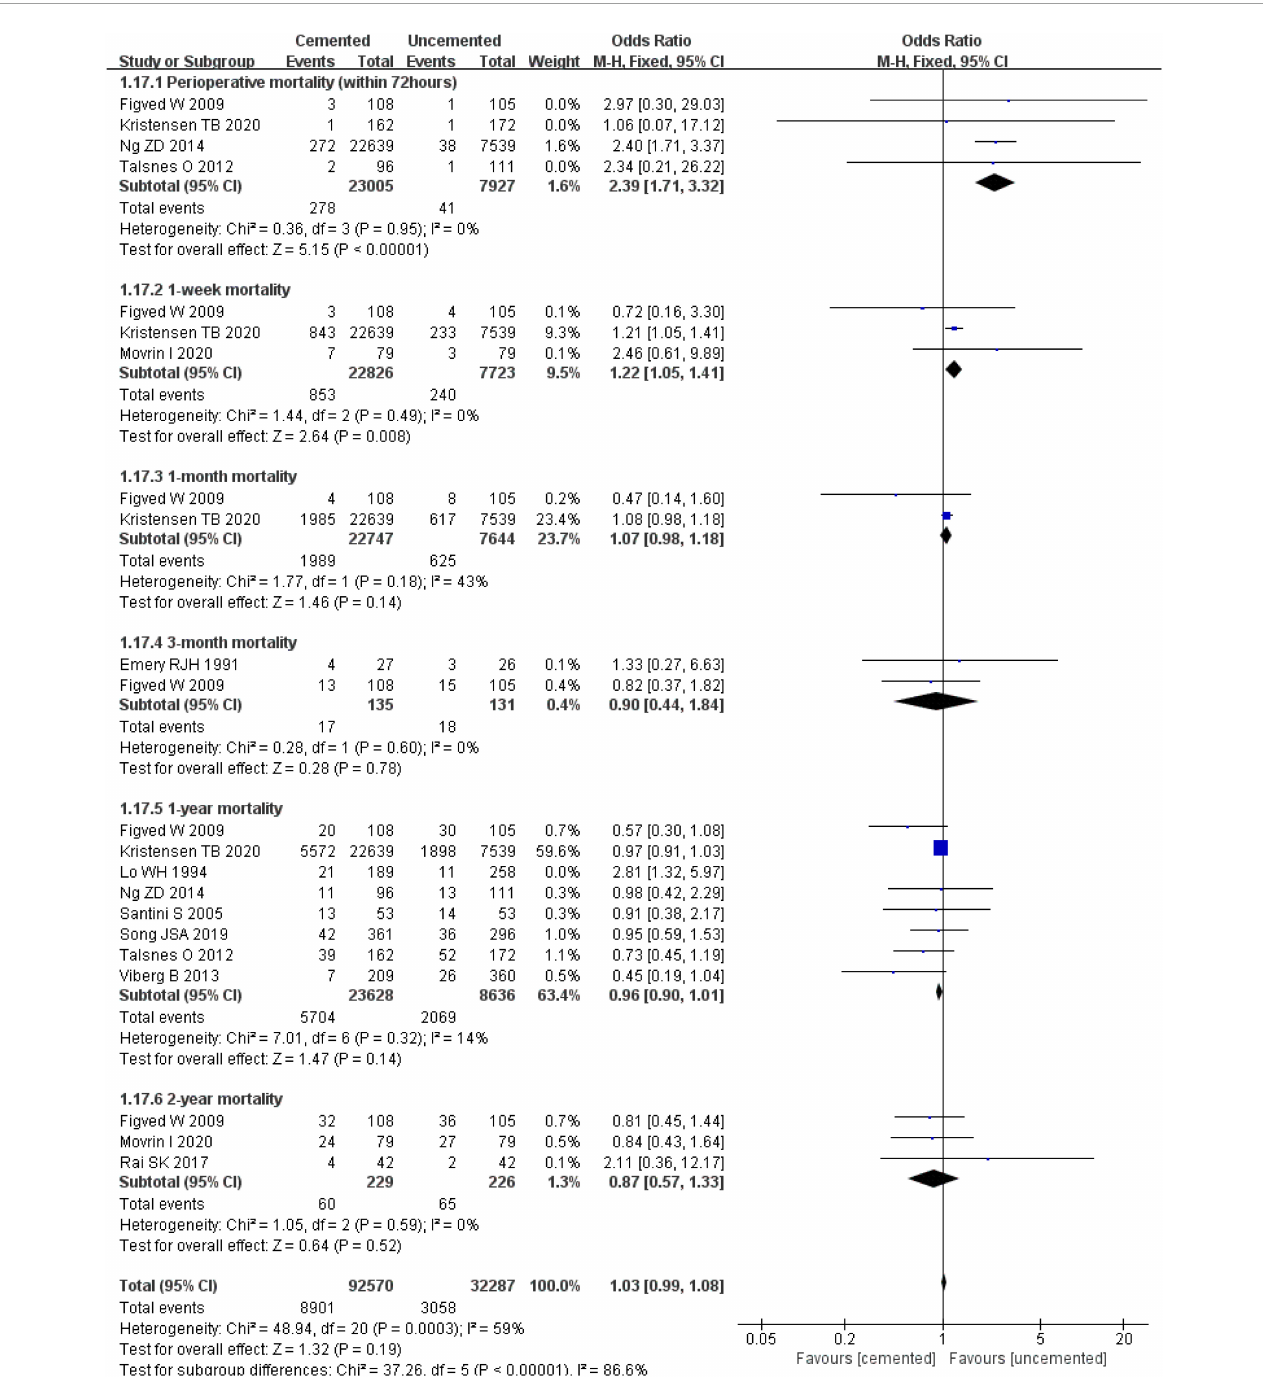
FIGURE19 Forest plot for comparison of mortality between cemented bipolar hemiarthroplasty (CBH) group and uncemented bipolar hemiarthroplasty (UCBH)